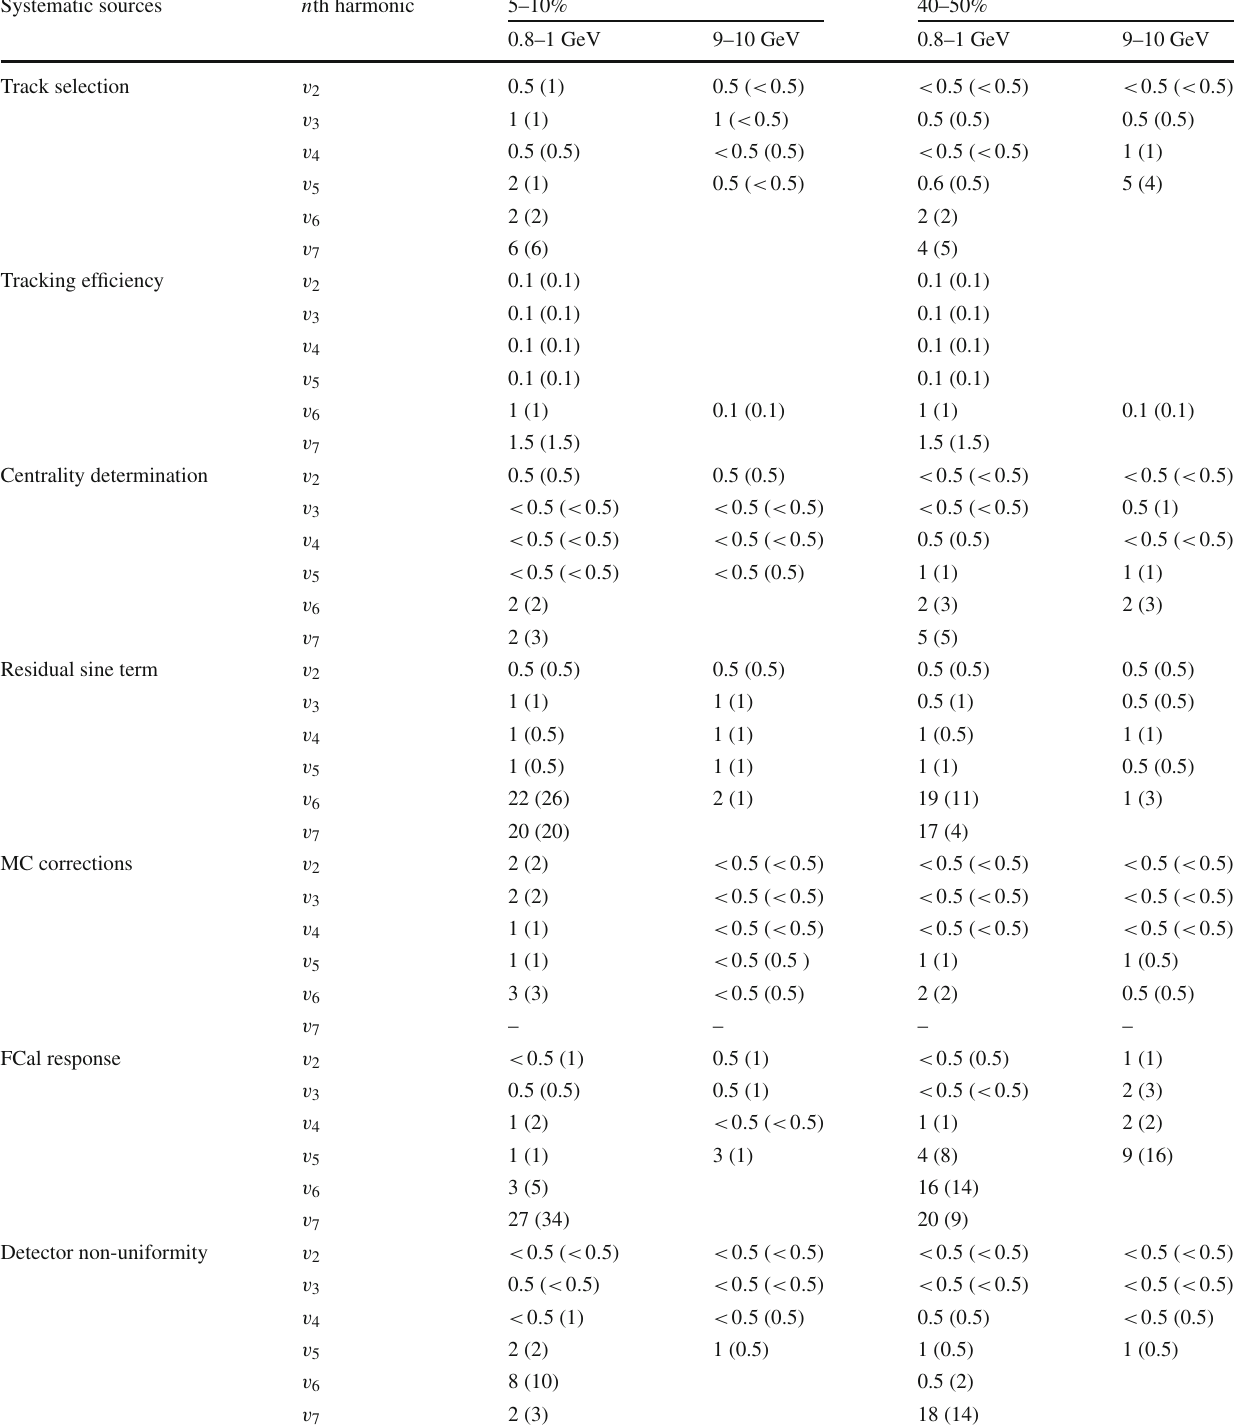
Table 4 The systematic uncertainties associated with the SP and EP (in parentheses) v n measurements for v n in 5–10% and 40–50% centrality bins. The contributions are expressed in %. The total systematic uncer- Systematic